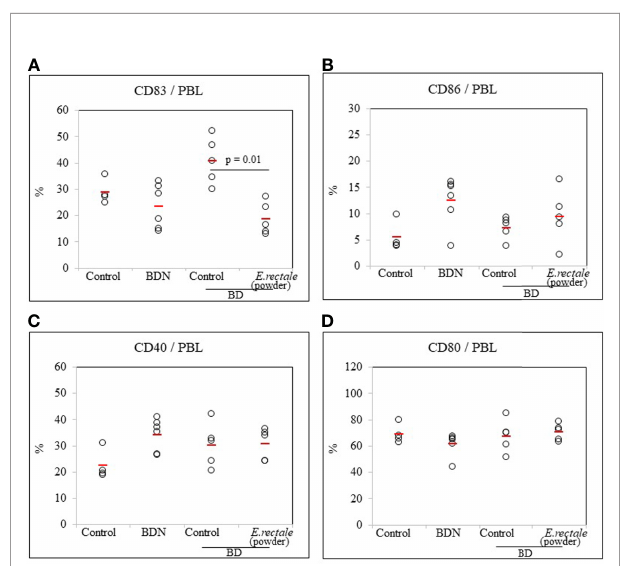
FIGURE 8 | FACS analysis of the frequency of DC activation markers in BD mice after administration of lyophilized E. rectale (A – D) . The p-value was determined by the Kruskal-Wallis test. The experiments were performed more than three independent